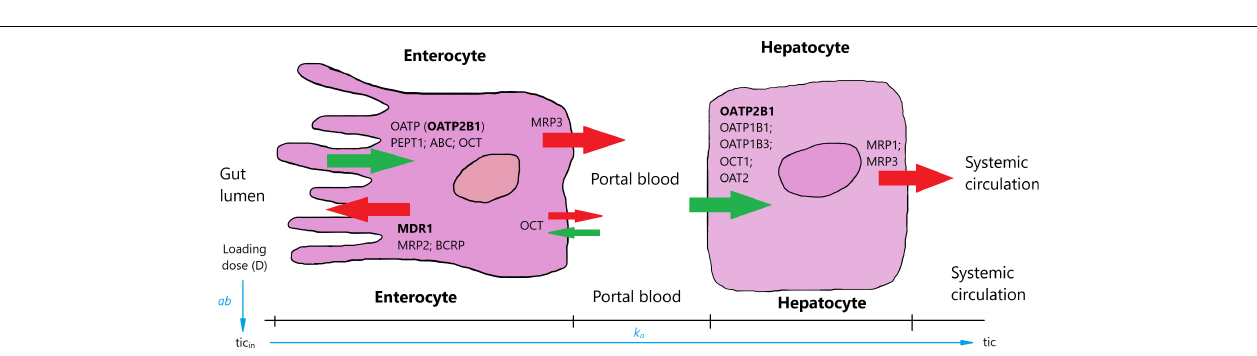
FIGURE 1 | Schematic representation of the two-compartment model of ticagrelor’s pharmacokinetics.